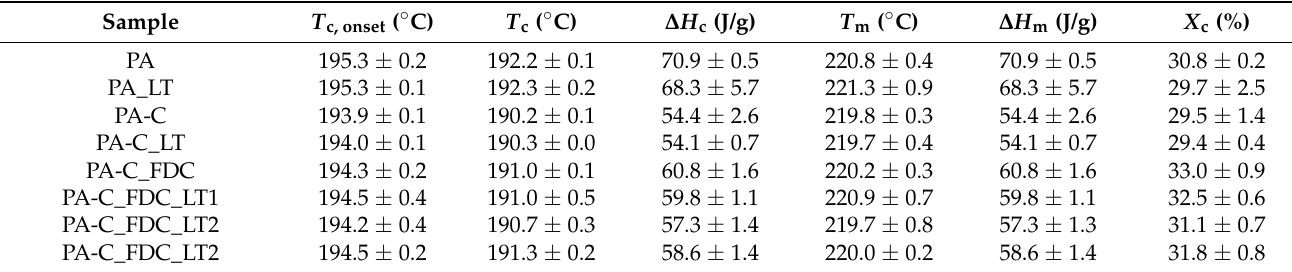
Table 3. Thermal properties of samples determined by